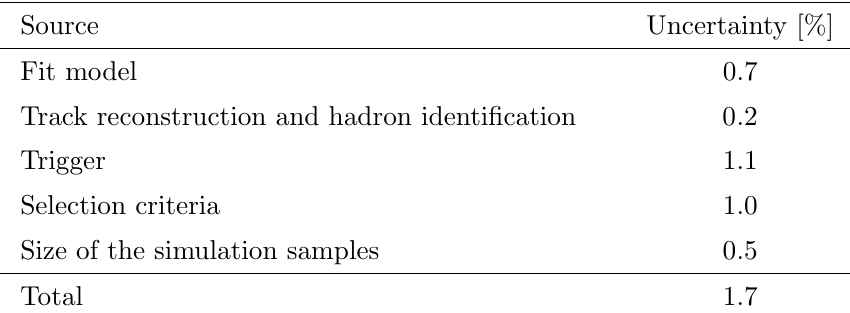
Table 1 . Relative systematic uncertainties for the ratio of branching fractions. The total uncer- tainty is the quadratic sum of the individual